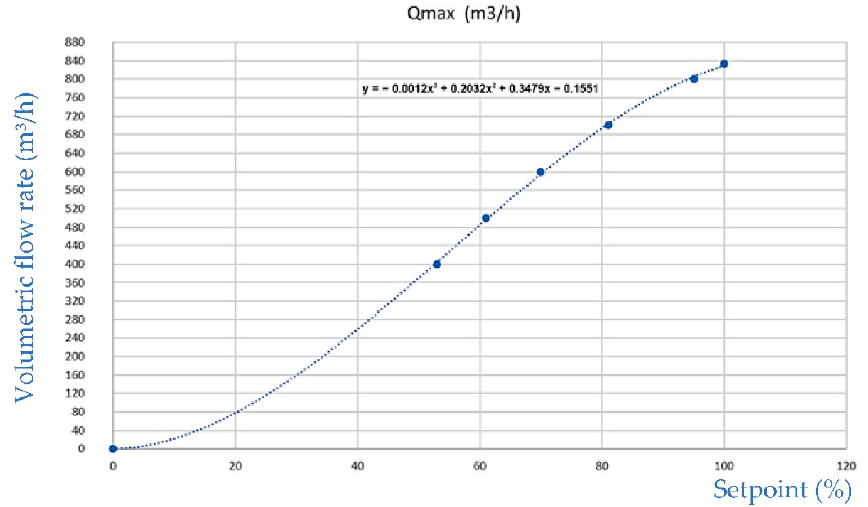
Figure 8. Adjustable flow rate of air filtration device.